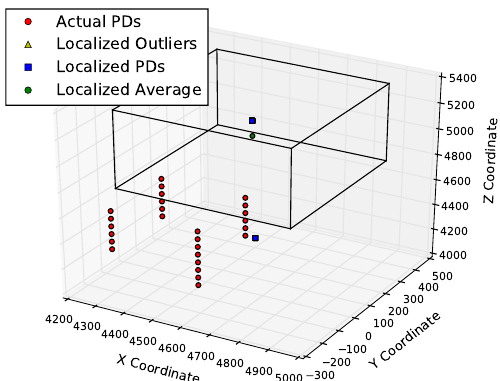
Figure 13. Localization results of cumulative energy are usually more than 300 mm away from the actual PD2 locations. The three axes are three dimensions of space (in mm).